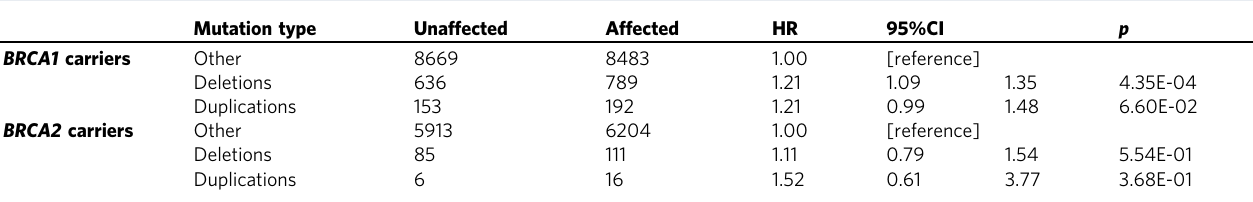
Table 1 Breast cancer hazard ratio estimates using a single model comparing other BRCA1/2 pathogenic variants versus (1) deletions, and (2) duplications a .